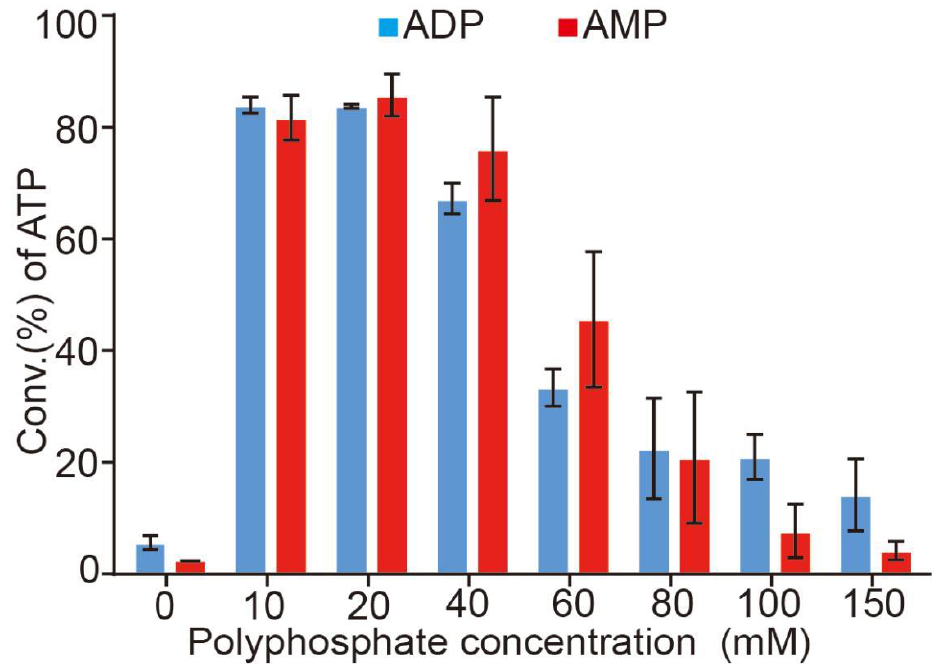
Figure 6. Effect of polyphosphate concentration on ATP synthesis. Productivity was assayed in 4 ADP or AMP, 30 mM Mg 2+ , and 50 mM Tris − HCl buffer (pH 8.5) at 37 ◦ C with the concentration of mM ADP or AMP, 30 mM Mg 2+ , and 50 mM Tris−HCl buffer (pH 8.5) at 37 °C with the concentration of polyphosphate from 0 – 150 mM. Results from three independent experiments were quantified. polyphosphate from 0–150 mM. Results from three independent experiments were quantified. Error Error bars represent SD of three independent experiments. bars represent SD of three independent